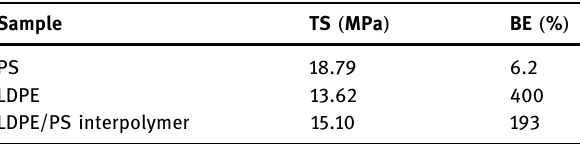
Table 3: Mechanical properties of PS, LDPE, and LDPE/PS interpolymer resin